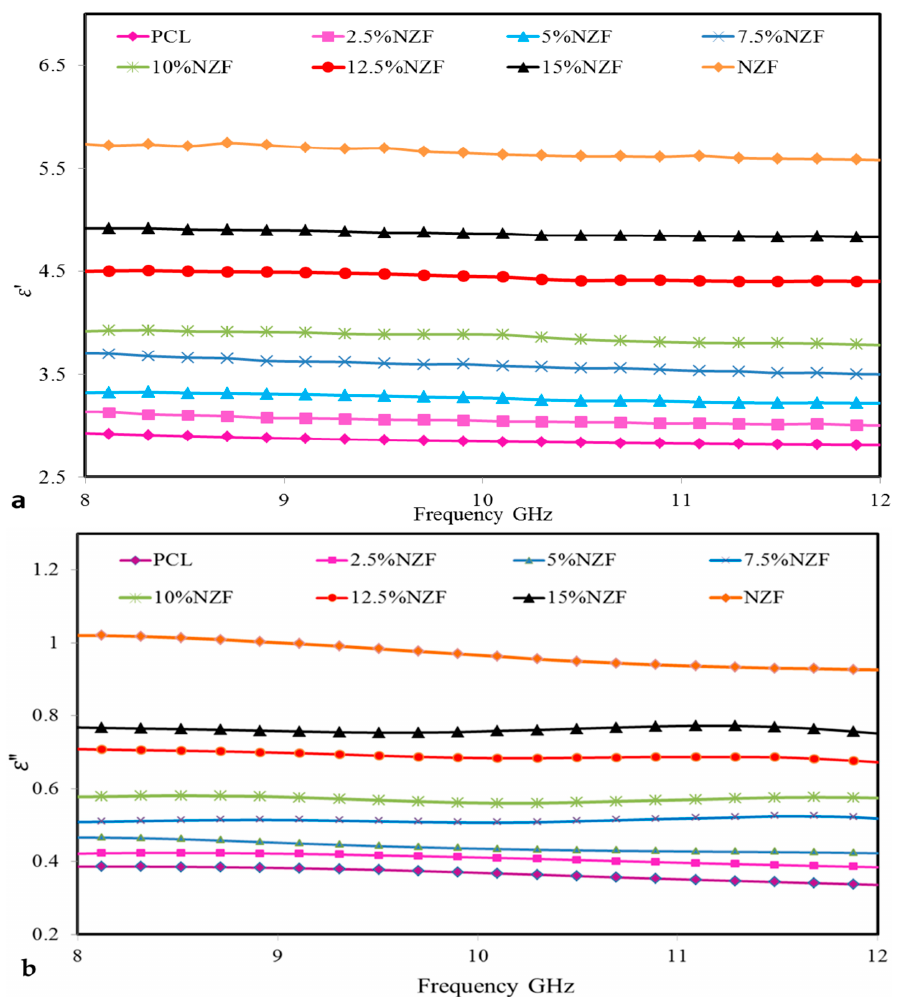
Figure 7. Variation in ( a ) Effective (relative) permittivity ε′ ( b ) Imaginary part of the relative permittivity ε″ with frequency for NZF + OPEFB + PCL composites.